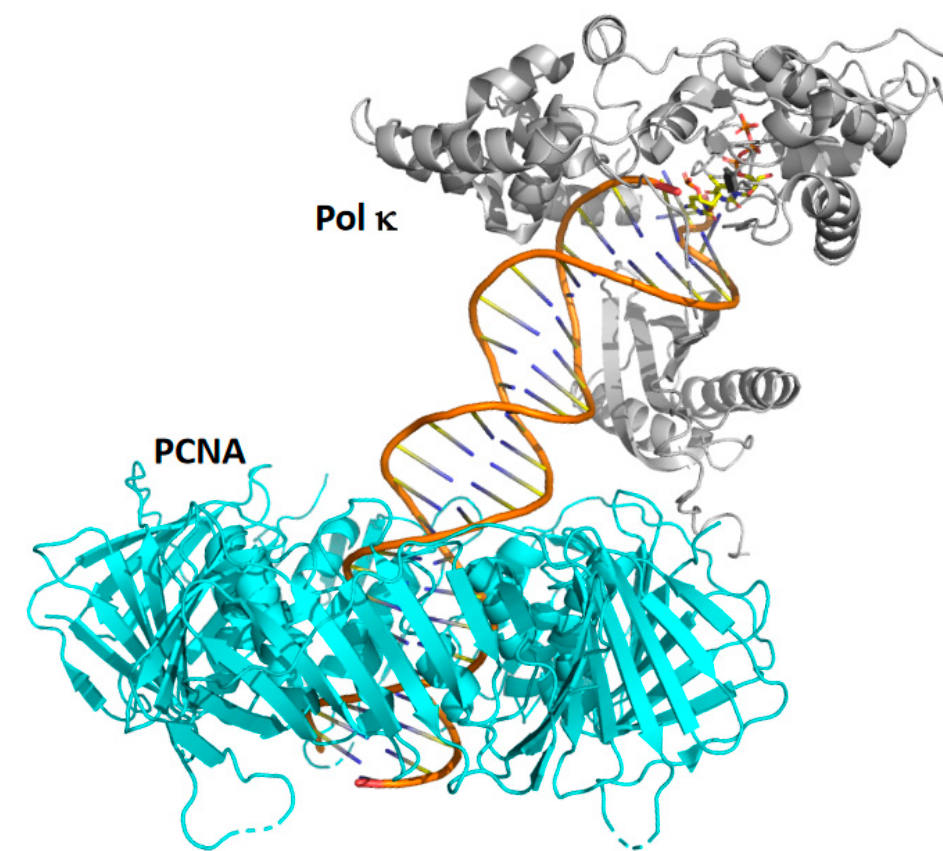
Figure 5. Cryo ‐ EM structure of full ‐ length pol κ bound to PCNA and DNA. Shown is a side view of pol κ bound to PCNA and DNA. Pol κ is shown in grey, and PCNA is shown in cyan. For the substrates in the active site, carbon atoms are shown in yellow, nitrogen atoms are shown in blue, oxygen atoms are shown in red, and phosphorus atoms are shown in orange. This figure was generated with 7NV0.pdb [67].